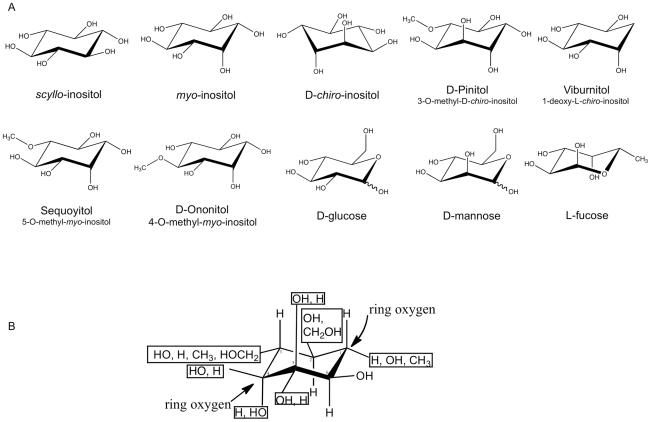
Basic structural model for SMIT1/2 substrate transport competitors.The structures of the substrates which competed for SMIT1/2 myo-inositol-(2-3H) transport (A), along with the structures of substrates that did not compete, were used to design a basic structural model for SMIT1/2 substrate transport competitors (B).